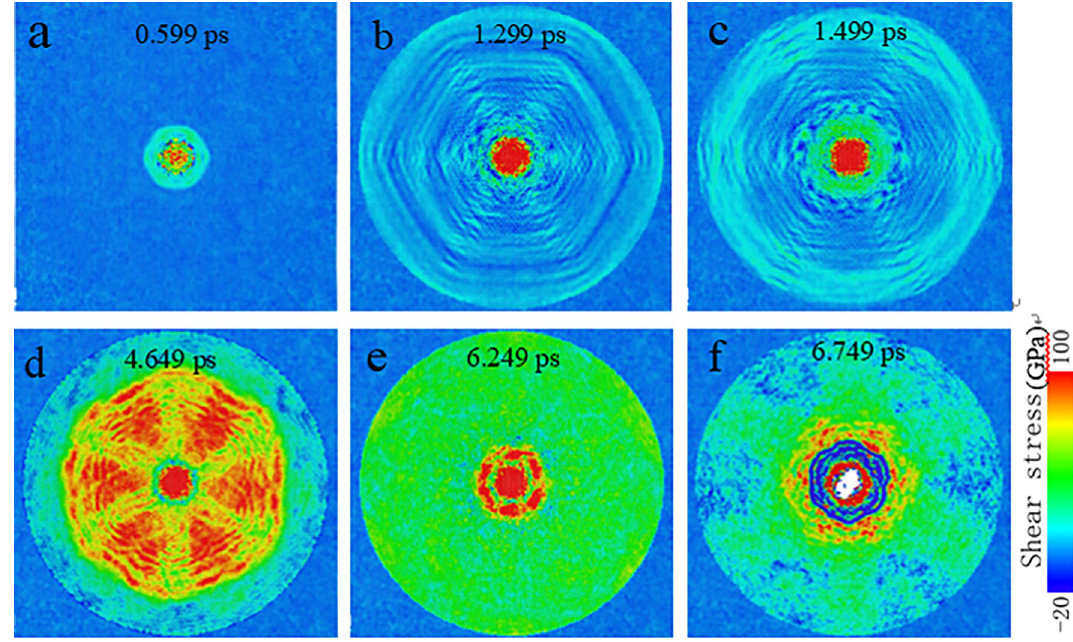
Figure 4. Propagation, reflection and convergence of stress waves in graphene membrane when subjected to the impact of diamond projectile at an initial impact velocity of V 0 = 2750 m/s. Shear stress is identified and visualized by Ovito Version 2.9.0 (https:// www. ovito.